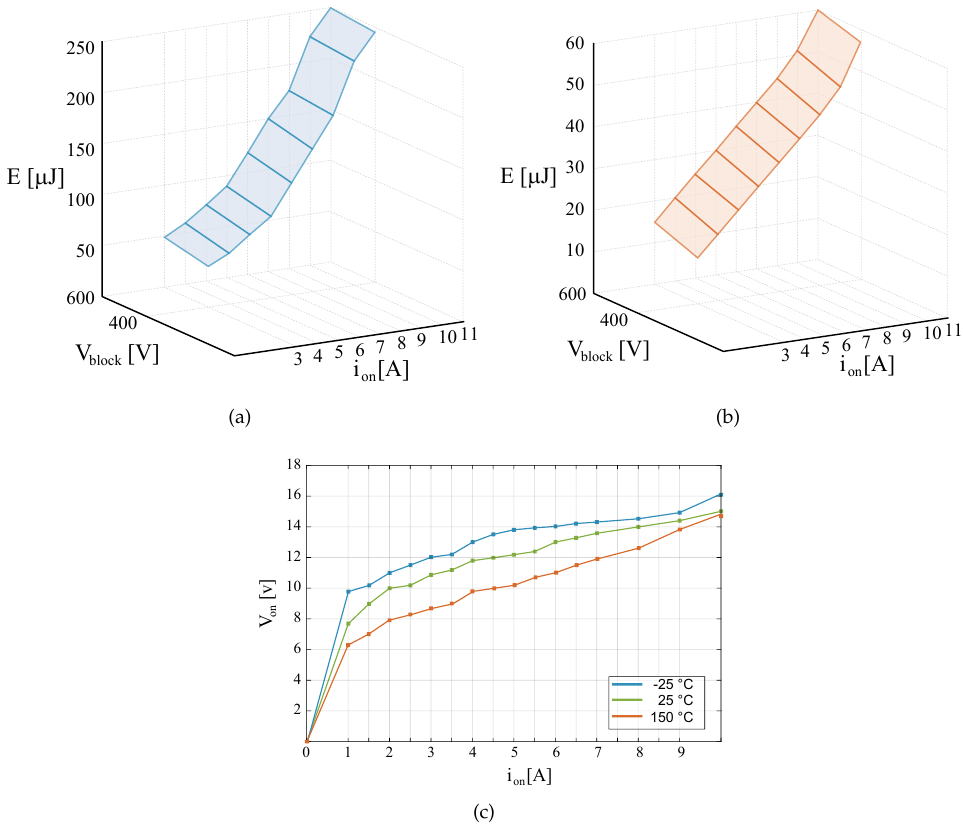
Figure 4. Switching and conduction losses of SCT2450KEC parameters of PLECS: ( a ) Turn on losses, ( b ) Turn off losses ( c ) Conduction